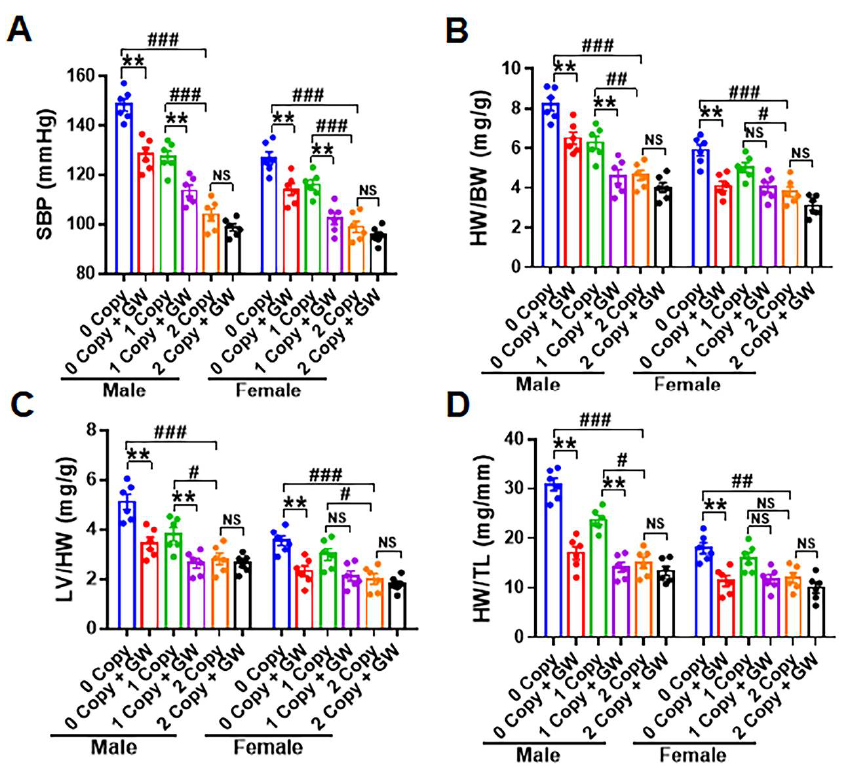
Figure 6. Sex-based analysis of the systolic blood pressure and cardiac hypertrophy in Npr1 0-copy, 1-copy, and wild-type 2-copy male and female control and GW788388-treated mice: the SBP, HW/BW, LV/BW, and TL/HW ratios are shown in panels ( A – D ). Values are expressed as means ± S.E. (n = 6 animals in each group). Statistical significance is expressed as # p < 0.05, ## p < 0.01, ### p < 0.001, vehicle-treated 0-copy and 1-copy vs. 2-copy; ** p < 0.01, vehicle-treated 0-copy, 1-copy and 2 copy vs. drug-treated same gene copy number. NS: not significant.